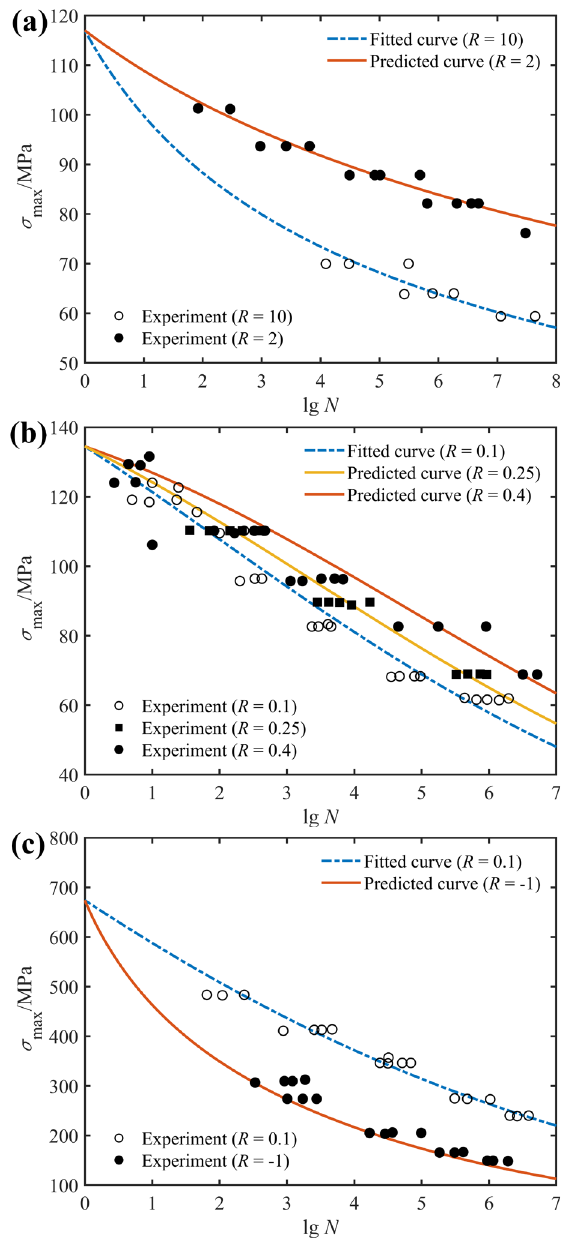
Figure 5. Fitted ( R = 10) and predicted ( R = 2) S - N curves of: ( a ) unidirectional glass/polyester [90°] 4 ; ( b ) S2/glass/epoxy with angle-ply configuration of [±45°] S ; ( c ) DD5E-glass/epoxy with stacking sequence of [0°/±45°/0°] S ; along with experimental data from Ref. [31].